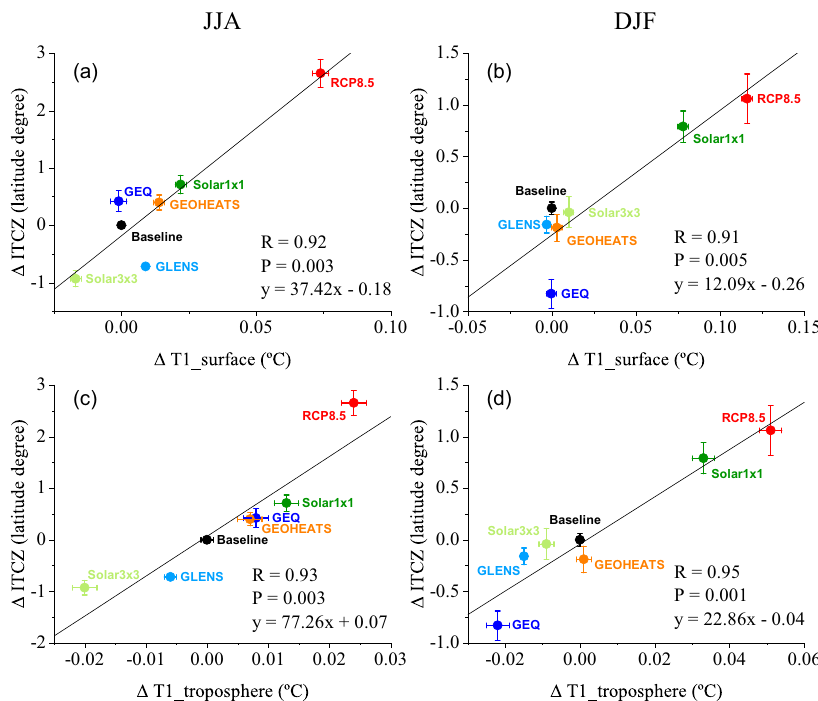
Fig. 4 The relationship between ITCZ shifts and two temperature metrics. Scatter plots of JJA average ( a , c ), and DJF average ( b , d ) ensemble mean changes in ITCZ, the north – south intertropical (30°S – 30°N) surface air temperature difference (T1_surface; a , b ) and the north – south intertropical mean troposphere (200 – 925 hPa) temperature difference (T1_troposphere; c , d ) under RCP8.5, GLENS, GEQ, Solar3x3, Solar1x1 averaged over years 2075 – 2095 ensemble mean, and GEOHEATS ensemble mean. Change is relative to the baseline period (RCP8.5, 2010 – 2030 average). Error bars represent standard error. ITCZ is de fi ned by the latitude closest to the equator where ψ m vertically averaged between 700 and 300 hPa is zero 58 . Positive values for ITCZ indicate northward